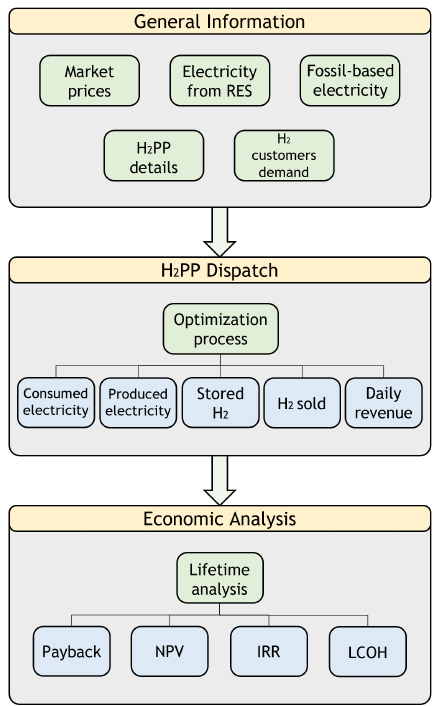
Figure 2. Overview of the H 2 PP’s technical and economic